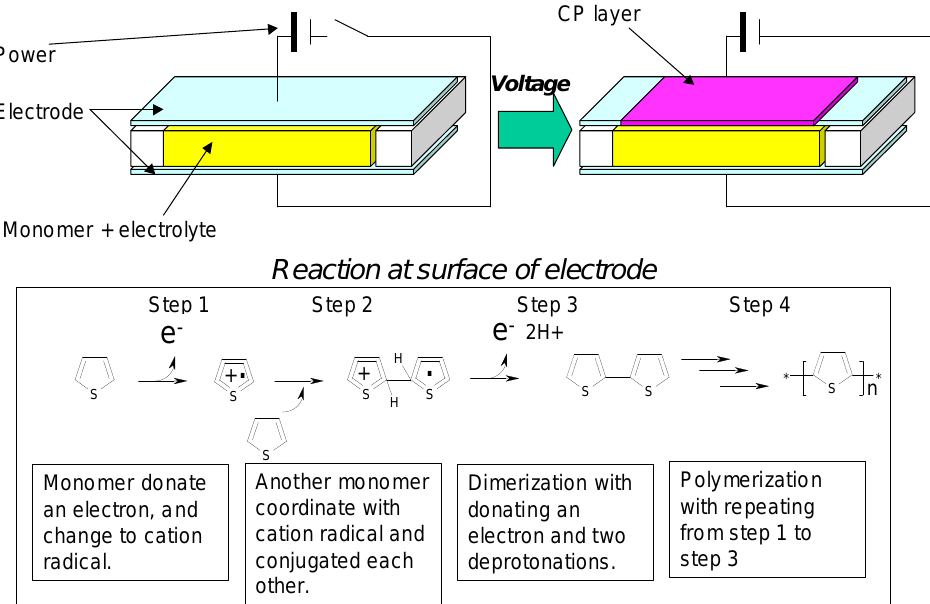
Figure 2. Mechanism of conductive polymer (CP)’s polymerization on